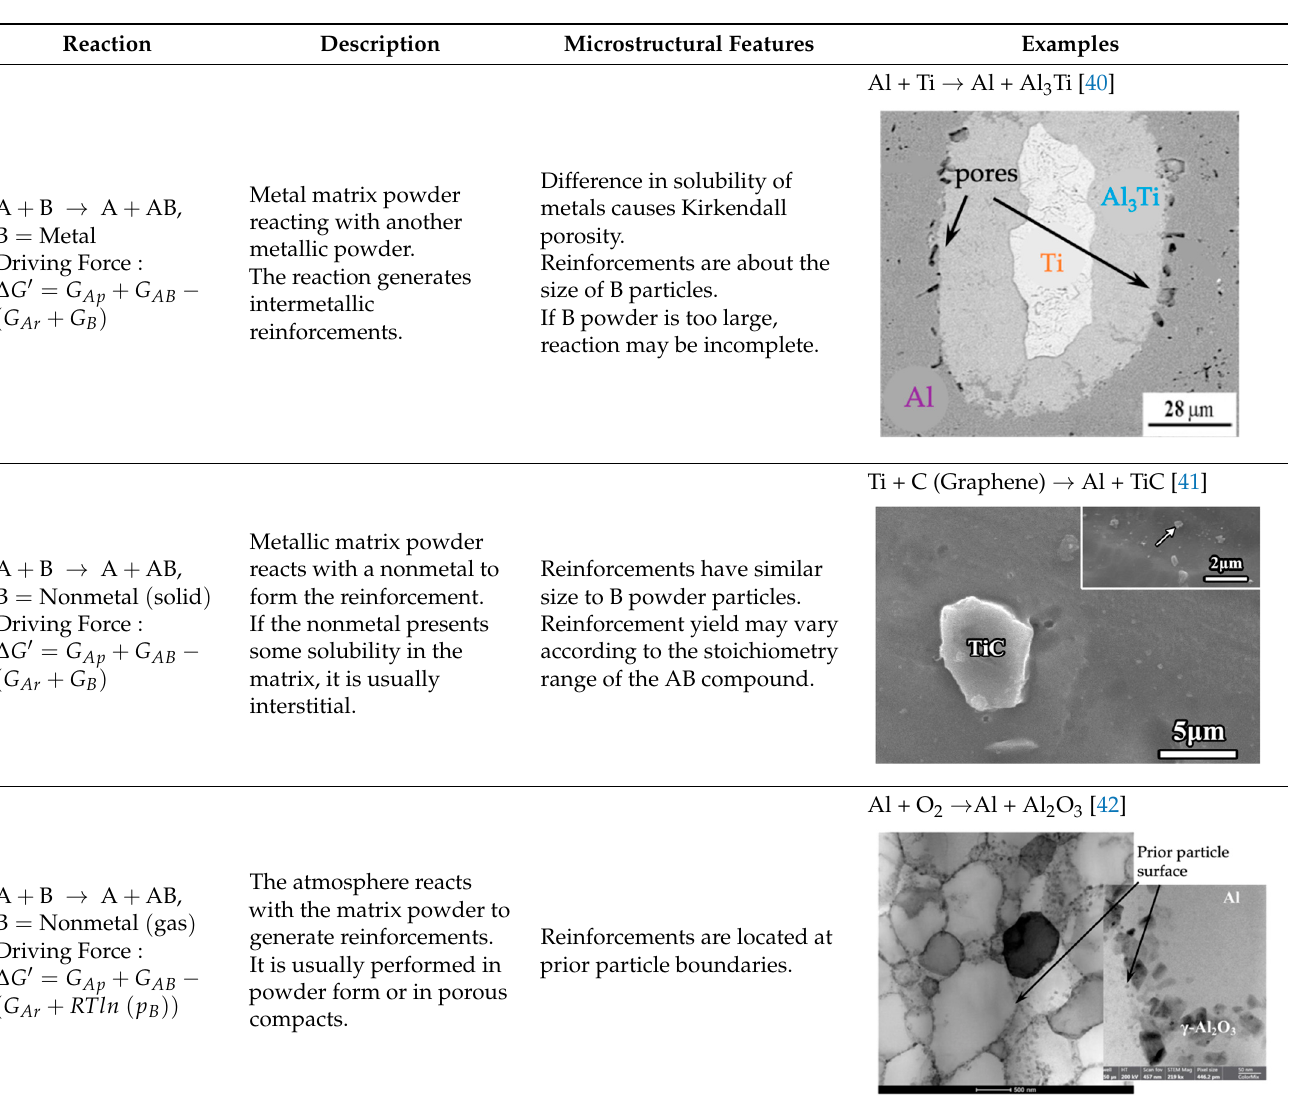
Table 1. Raw material possibilities for composites of type A + AB. Δ G is the Gibbs free energy change of the reaction, G is the Gibbs free energy of element i, and p B is the partial pressure of B in atm. R and P subscripts in the fourth column stand for reactant and product amounts of A, respectively. For the sake of simplicity, there is no mass balance in the reaction equations. Figures in the “examples” column are meant to illustrate microstructural features listed in the summary.